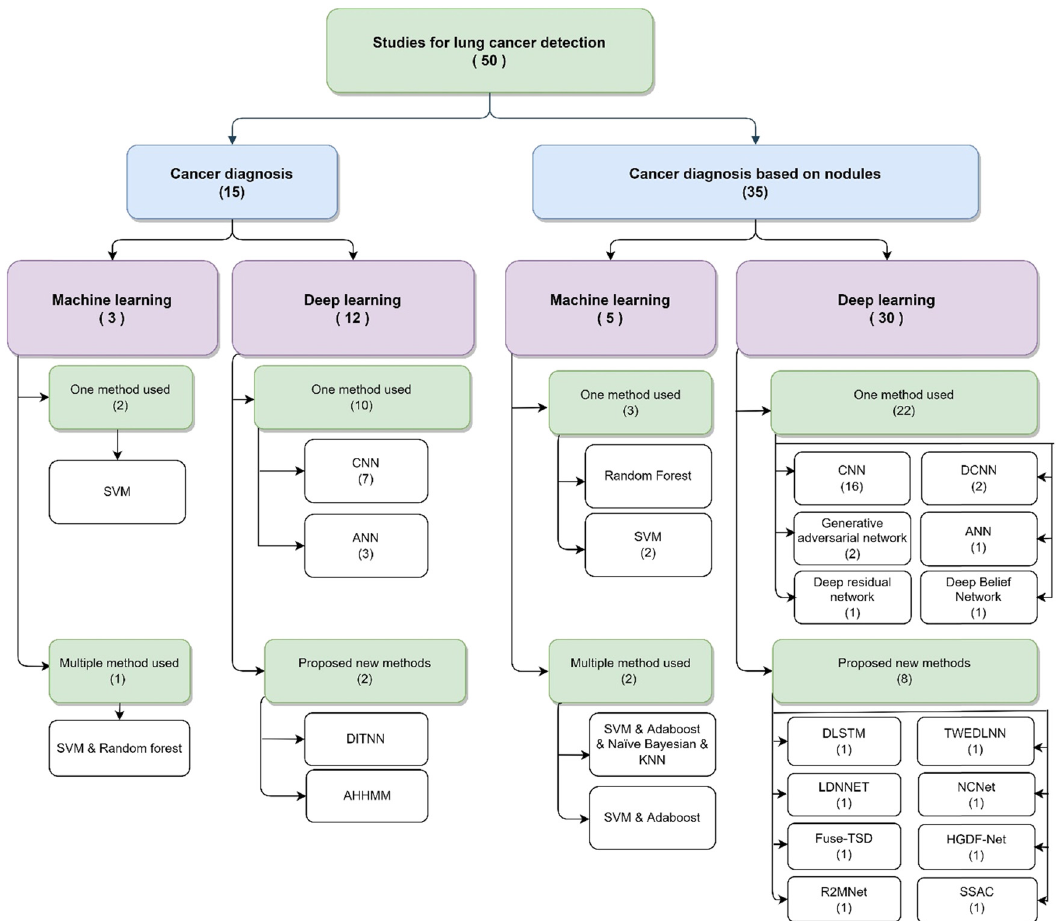
Figure 3: Taxonomy of studies of lung cancer